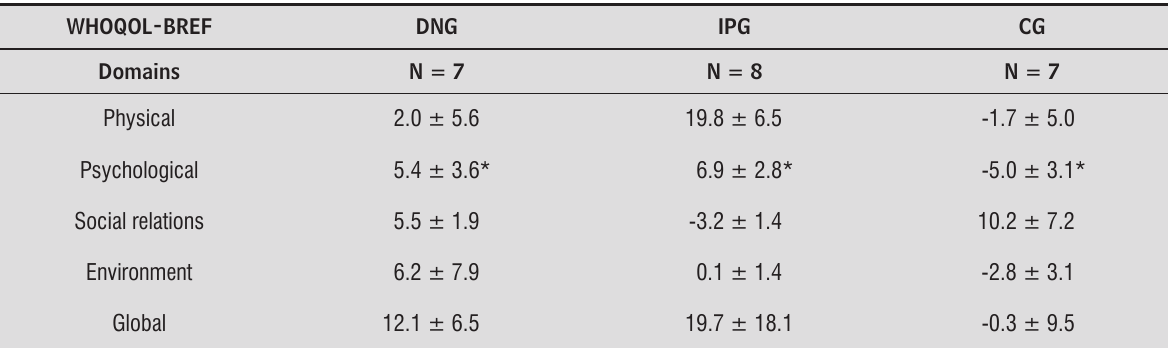
Table 2 - Change ( % ) of the World Health Organization Questionnaire of Quality of Life (WHOQOL-BREF) scores of each domains from